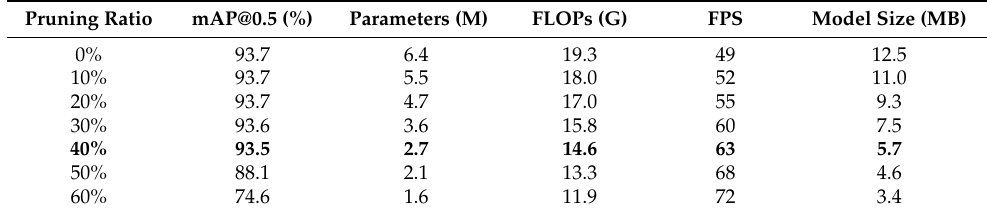
Table 3. Comparison of models with different pruning